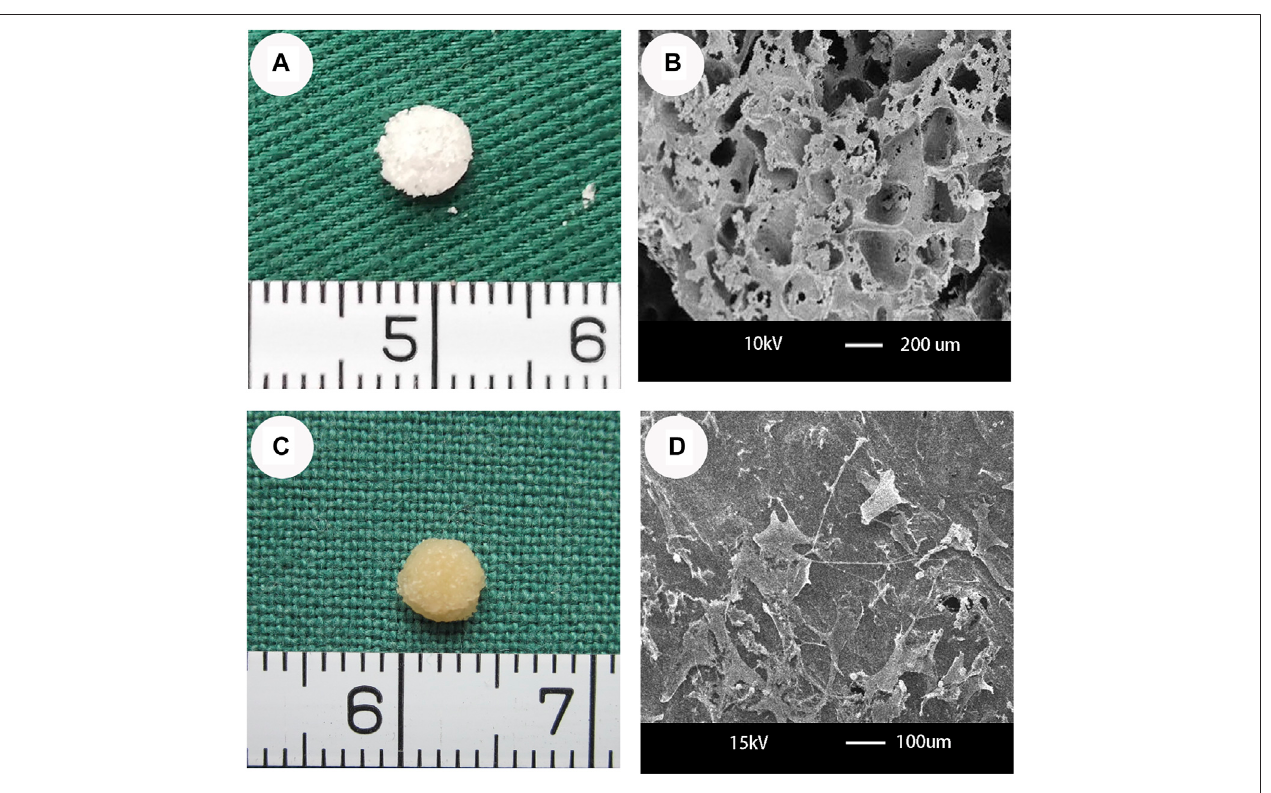
FIGURE 1 | Optical microscopy and SEM of PHBV/10%Bioglass scaffolds and the CPC – PHBV/10%Bioglass construct. (A) The PHBV/10%Bioglass scaffolds exhibited a cylindrical shape (5 mm diameter and 2 mm thickness), with a lot of pores on the surface of the composite scaffolds. (B) PHBV/10%Bioglass composite porous 3D scaffolds had a macroporous structure with interconnected open pores of 30 – 300 μ m in diameter. (C) Gross view of in vitro CPC – scaffold constructs after 6 weeksof invitro culture.Theseengineeredtissuesroughlymaintainedtheiroriginalcylindricalshapeandsizeandexhibitedanivory-whitishappearance. (D) SEM view of CPCs-PHBV/10%Bioglass constructs after 6 weeks of in vitro culture, exhibiting abundant extracellular matrix production and good compatibility of the CPCs with the composite